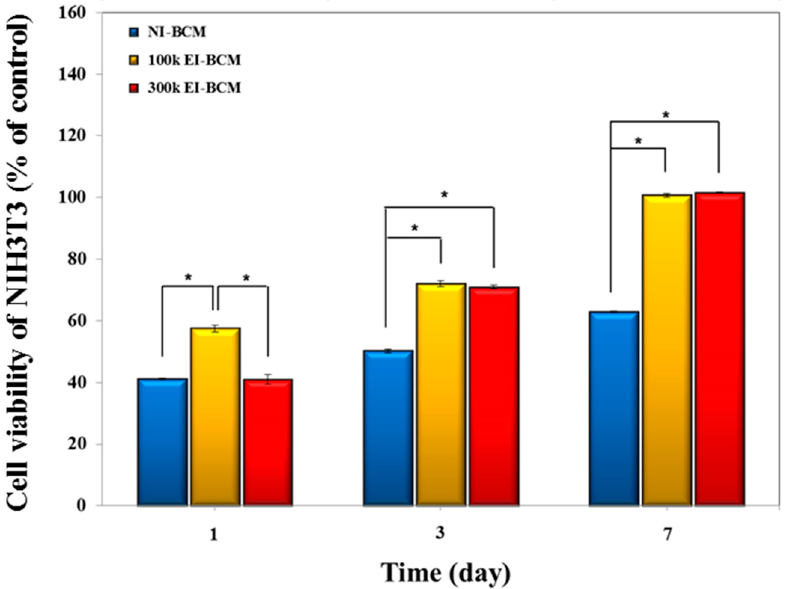
Figure 6. Cell viabilities of NIH3T3 cells cultured on BCMs. CCK-8 assays showed that the viabilities of cells on 100k EI-BCMs and 300k BCMs were significantly greater than those on NI-BCMs after 3 and 7 days (* p < 0.05).